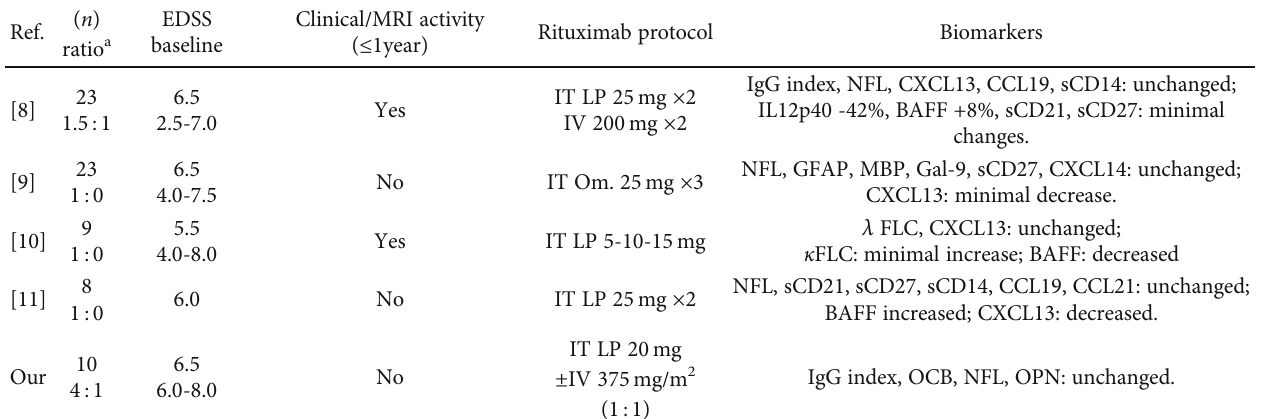
Table 2: Studies of intrathecal rituximab in progressive